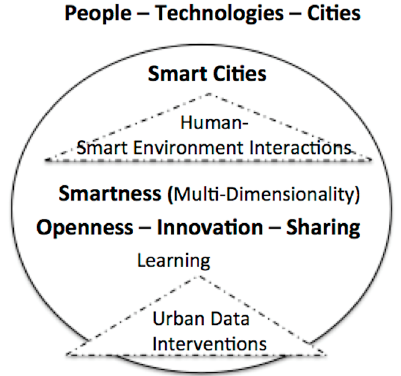
Figure 3. Human-smart environment interactions (HSEI) conceptual framework for smartness and dimensional relationships in smart cities.